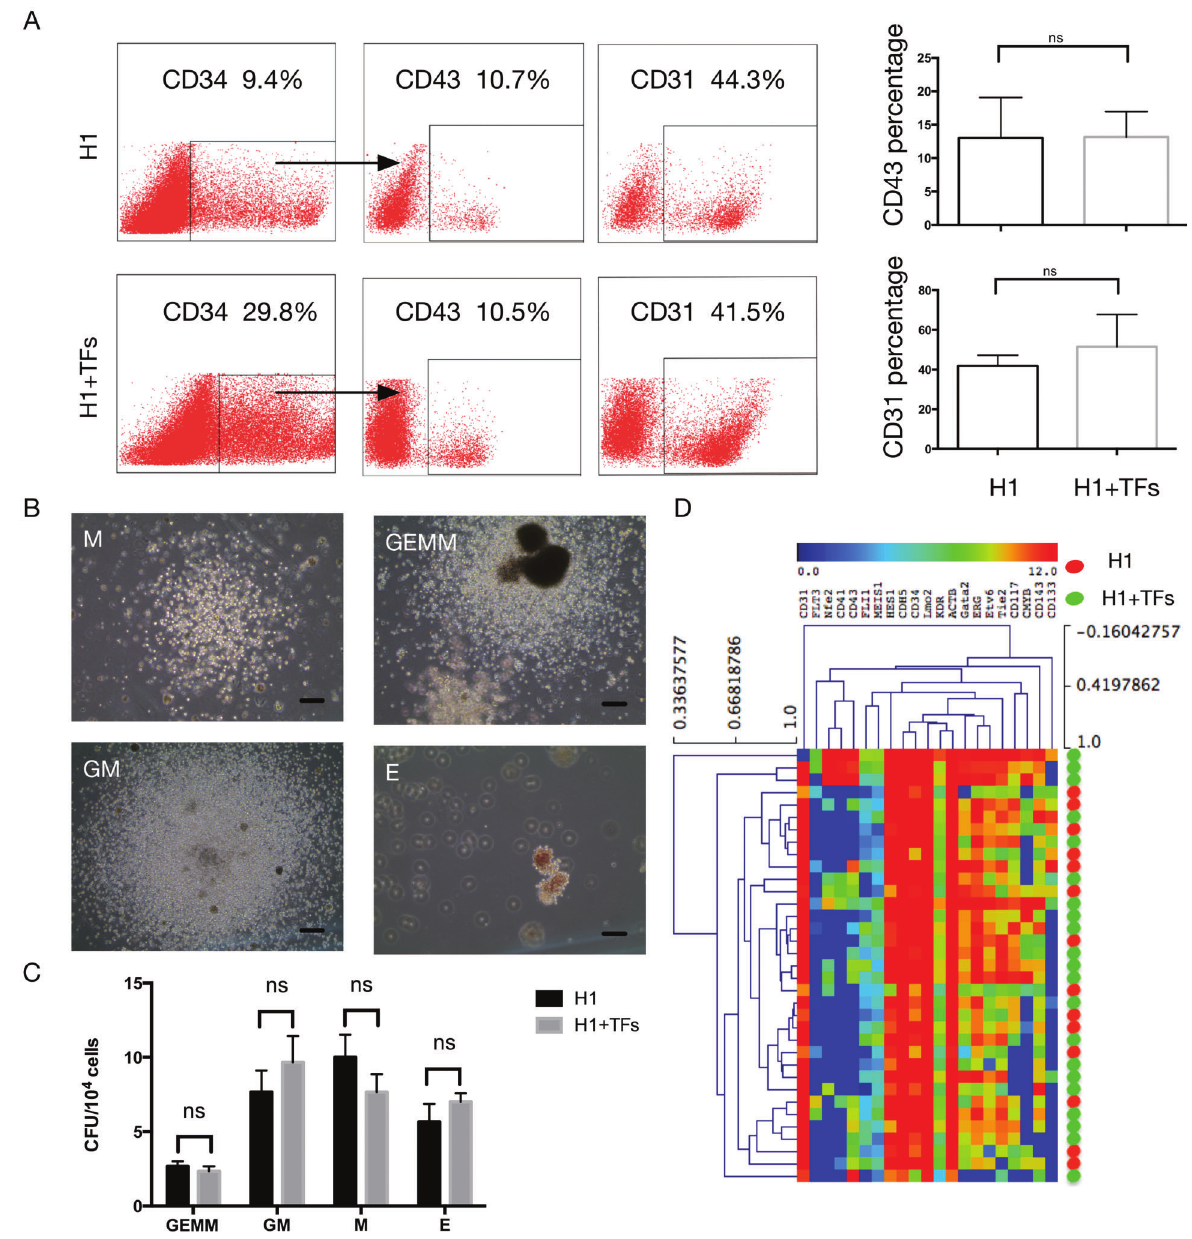
Figure 5. Expression and functional analysis of CD34 + cells after transcription factors overexpression. A, Flow cytometry showing the percentage of CD43 + cells and CD31 + cells in CD34 + cells after transcription factors overexpression. H1: cells without lentiviral transduction; H1 + TFs: H1 transduced by lentivirus; n X 3. ns: P 4 0.05 ( t -test). B and C, Morphology of different colony-forming unit (CFU) types after transcription factors overexpression, including M, GM, GEMM, and E. Scale bar=100 m m; n X 3. ns: P 4 0.05 ( t -test). D, Heatmap of hierarchical clustering showing the expression characteristics of individual CD34 + from day 8. Red and green colors of each row correspond to individual CD34 + cells from H1 and H1 + TFs group respectively. Each column corresponds to a speci fi c gene. Color scale was set from 0 to 12. Blue to green suggests low to moderate gene expression (log2) and green to red suggests moderate to high gene expression